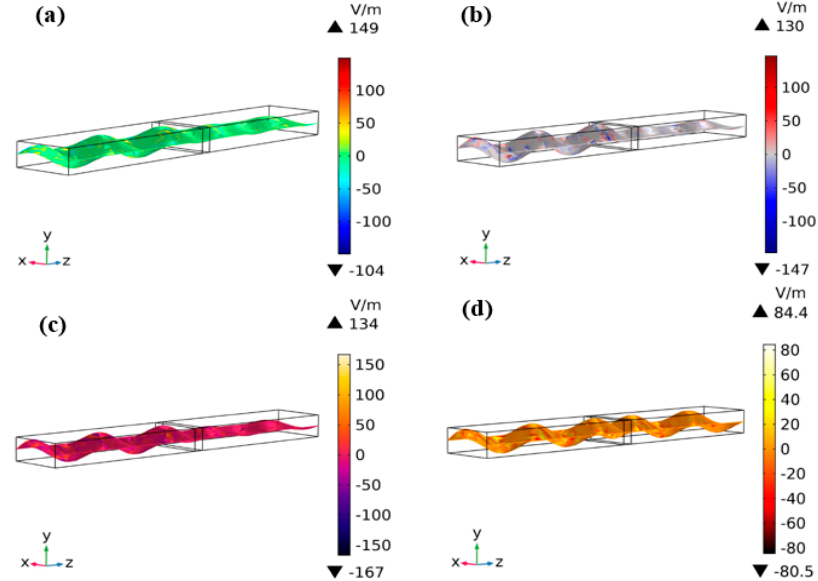
Figure 12. 3D electric field slice plot of X-band FEM simulated rectangular waveguides of all samples at 4.0 mm thickness and 11.2 GHz frequency.